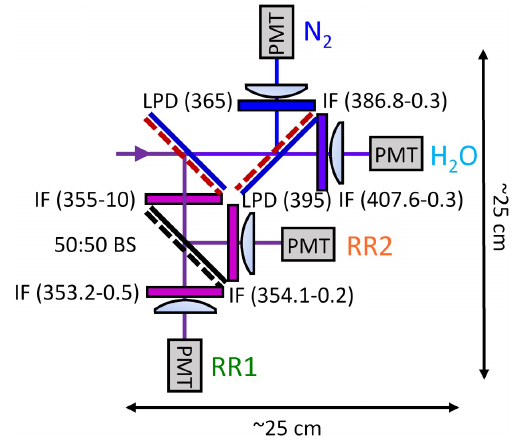
Figure 5. Compact rotational and vibrational Raman separation configuration used in WALI. IF: interference filter (with CWL– FWHM given in nanometers); BS: beam splitter; LPD: long-pass dichroic beam splitter (with cut-off wavelength given in nanome- ters); PMT: photo-multiplier tube. This polychromator is thermally regulated in a dedicated light-tight enclosure.